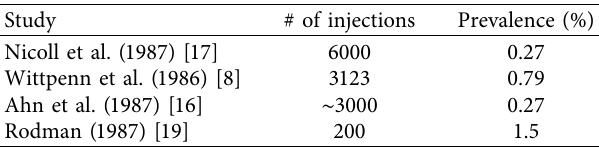
Table 1: Prevalence of brainstem anesthesia after retrobulbar